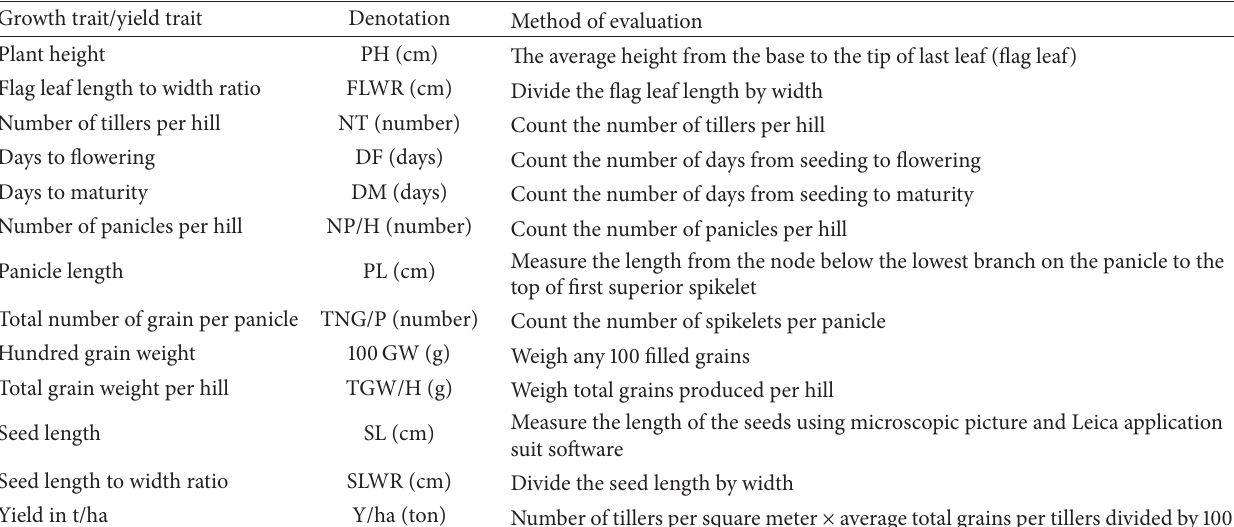
Table 2: List of quantitative